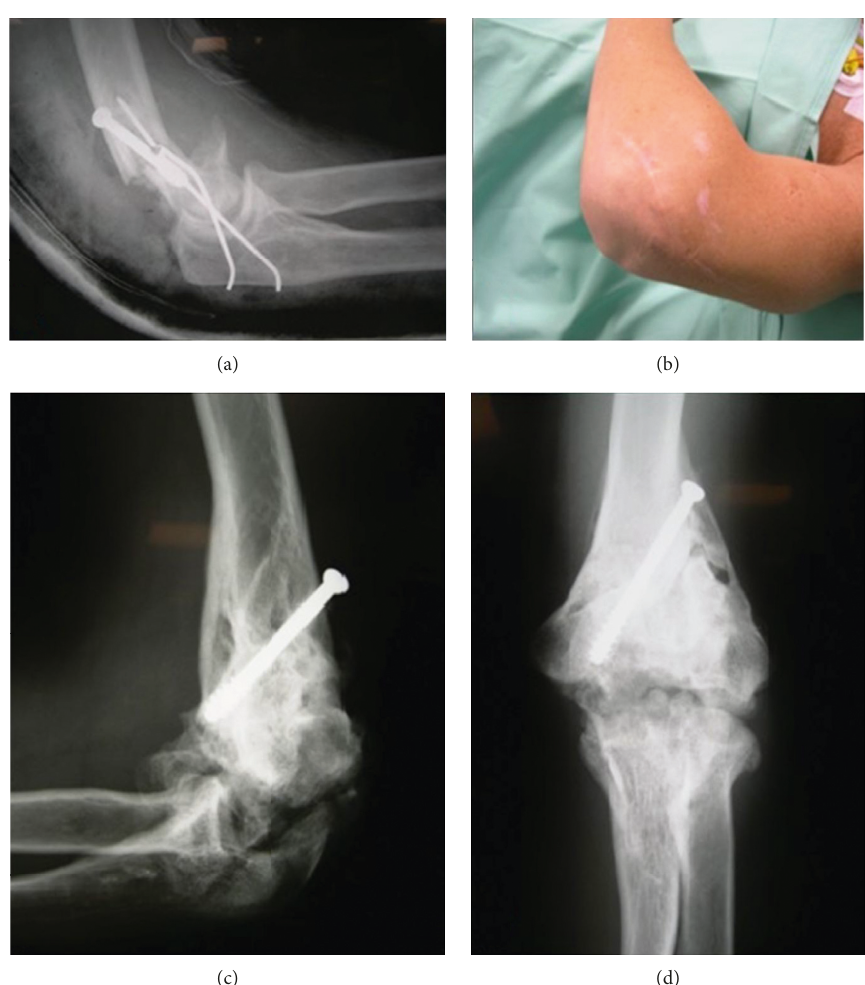
Figure 3: Direct postoperative radiograph showing the insufficient fracture fixation after previous surgery (a); the skin showing the scar following previous surgery (b); radiographs showing distal humeral malunion and generalized elbow joint osteoarthritis (c,